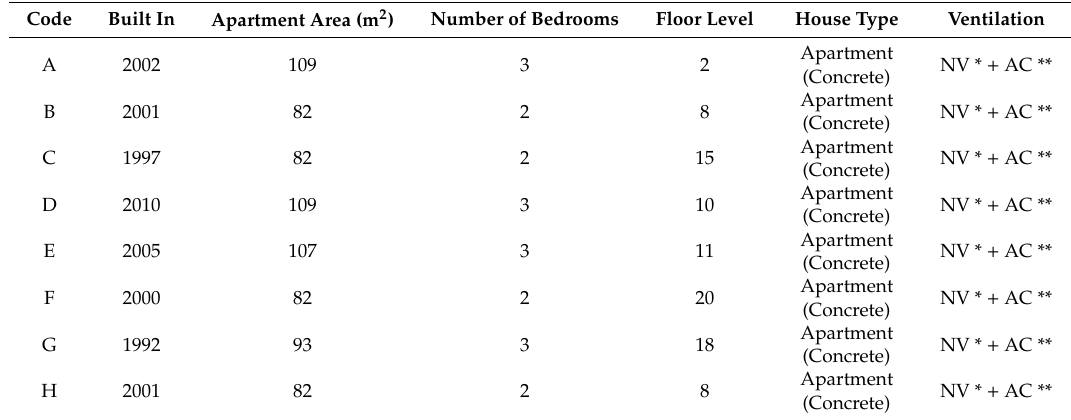
Table 1. Case study information on the dwellings.